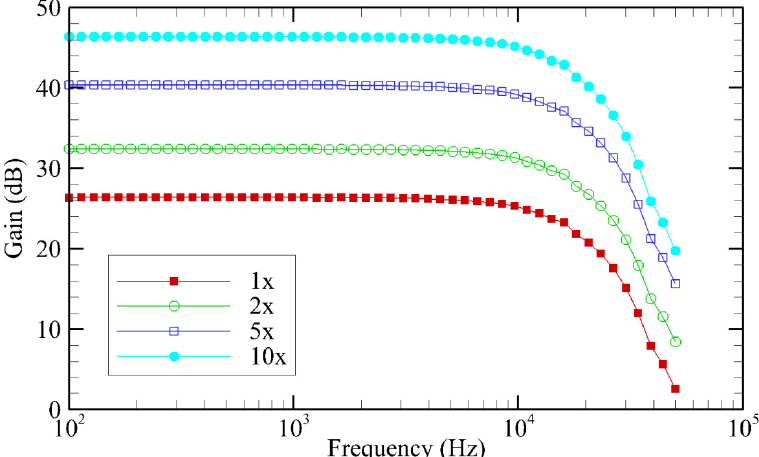
Figure 7. Average hydrophone signal processing board frequency response for each gain